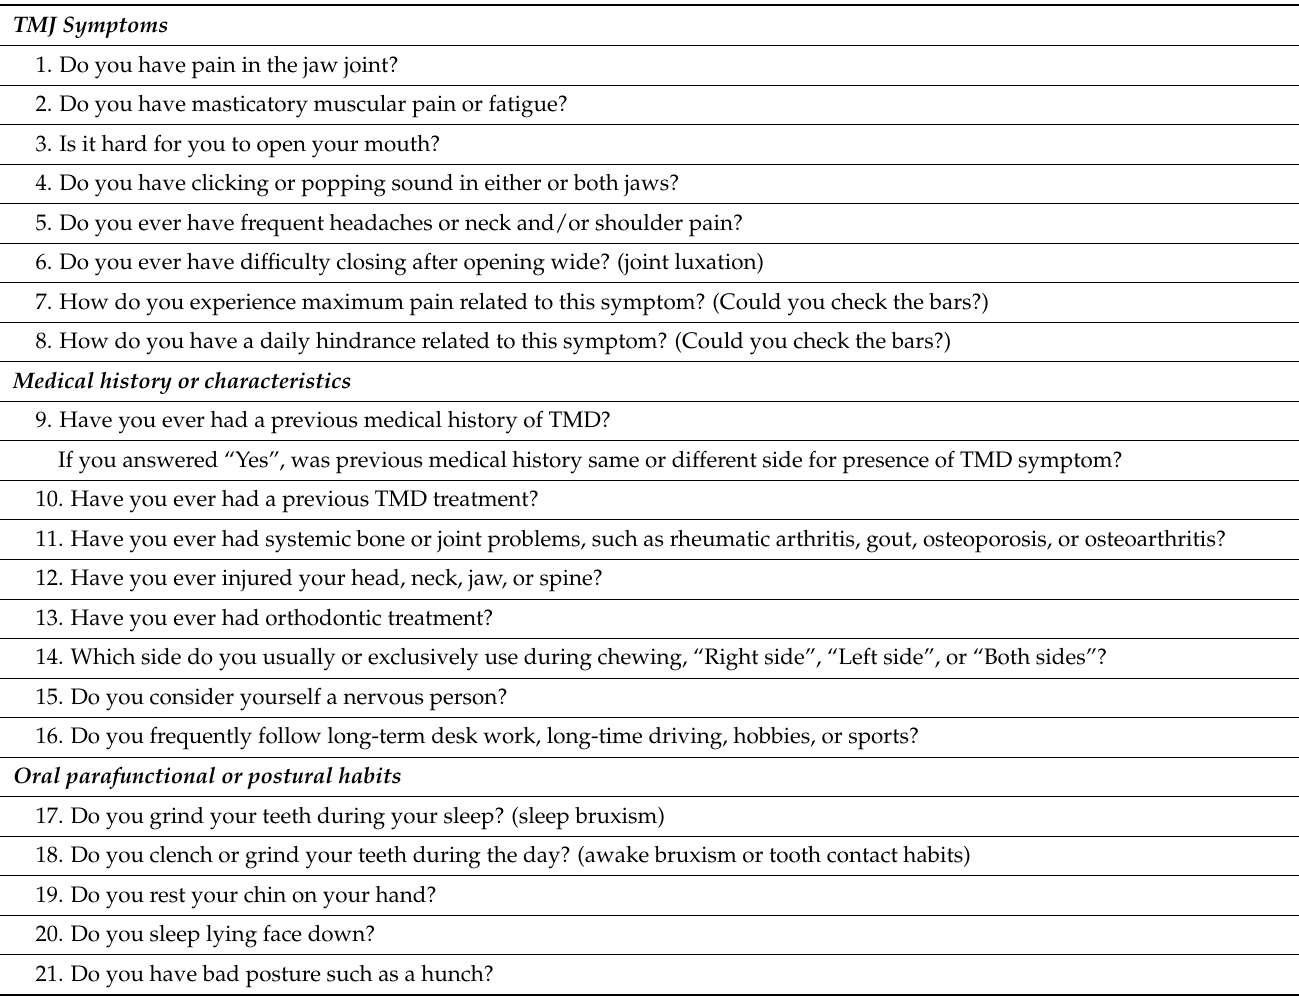
Table 1. Questions for patients with TMD at the initial